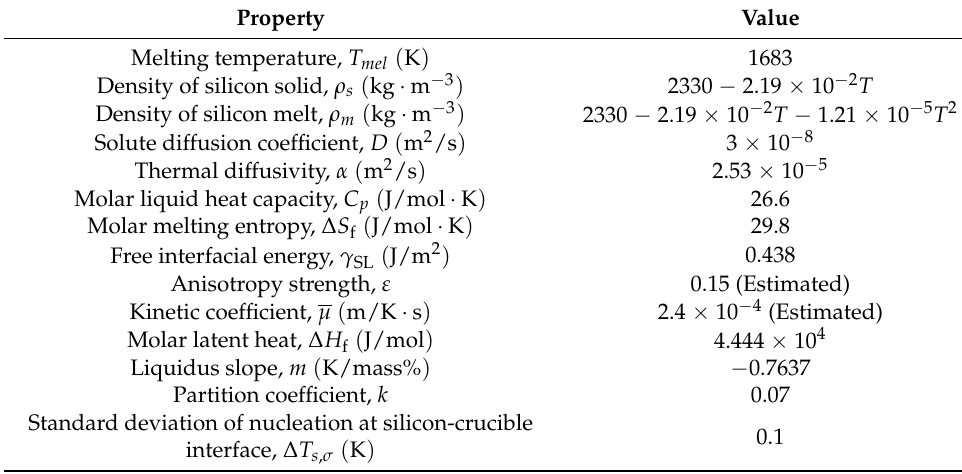
Table 1. Physical properties and calculation parameters used in the present model.